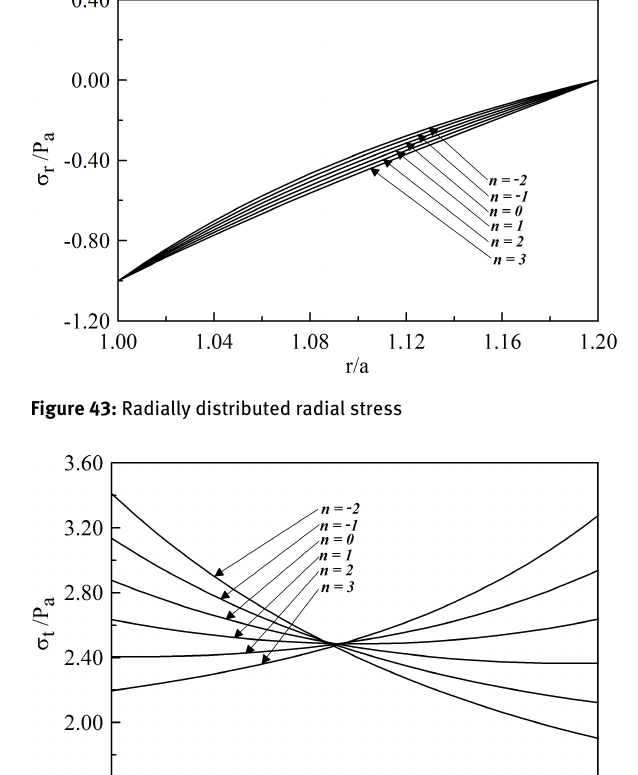
Table 1: For different cases 1-7 the von-Mises stresses ( σ * ) at b/a